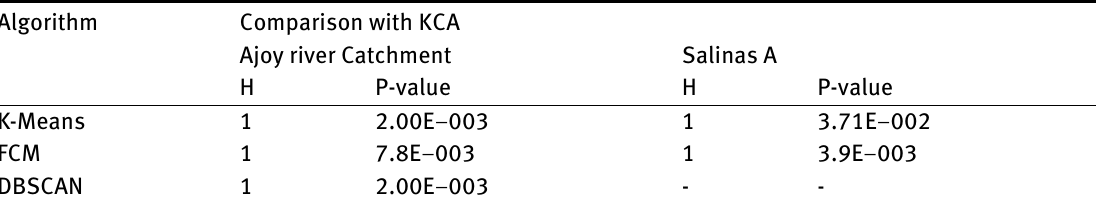
Table 10: P-values produced by rank sum test when in comparison for KCA with K-Means and KCA with FCM algorithms respec- tively